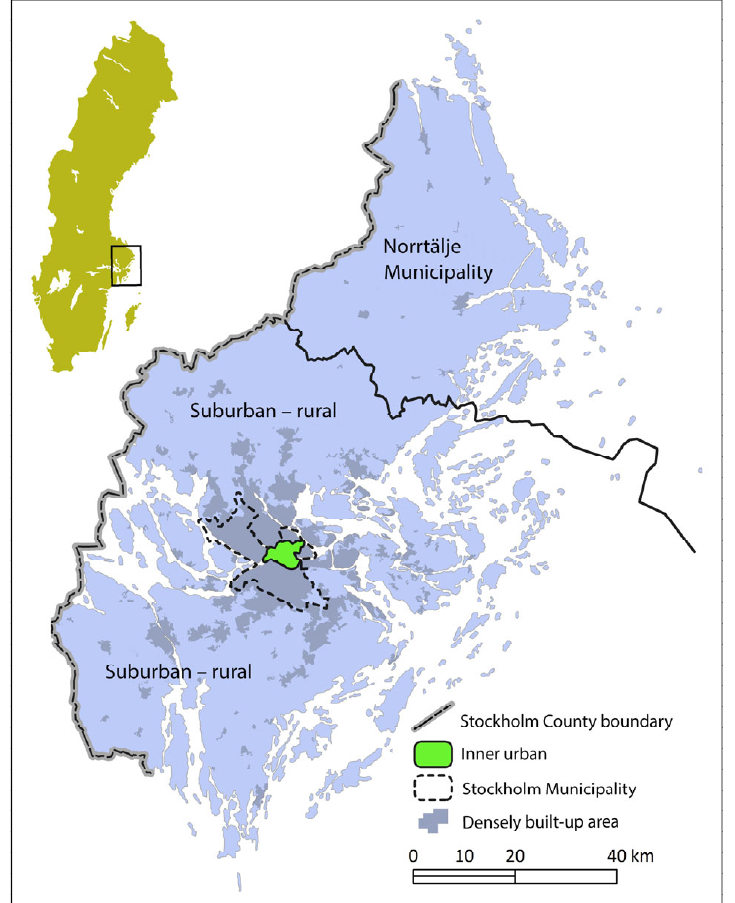
Figure 3. Map over Sweden and Stockholm County, with the inner urban study area of the Munici- pality of Stockholm in green. The marking for the densely built-up areas illuminates the conditions in 2010. North is at the top of the image.